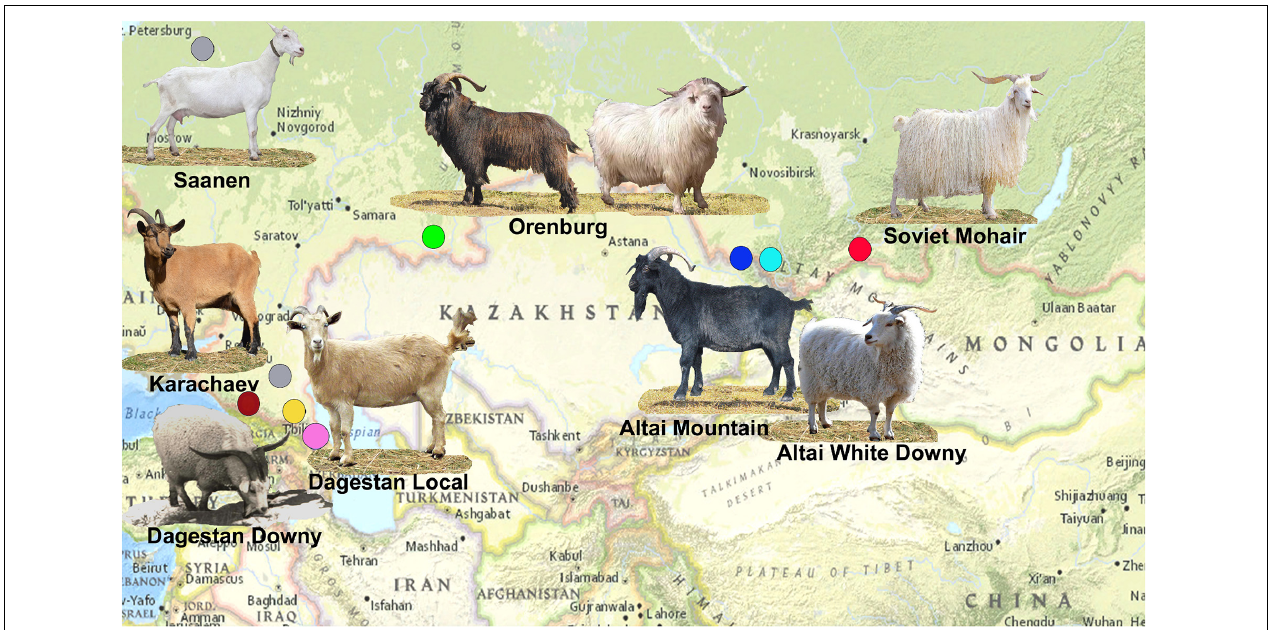
FIGURE 1 | Map illustrating the area of sampling for Russian goat populations. The sampling locations are shown as circles colored blue for Altai Mountain, cyan for Altai White Mountain, yellow for Dagestan Downy, pink for Dagestan Local, brown for Karachaev, green for Orenburg, gray for Saanen, and red for Soviet Mohair. The Orenburg breed is shown in two coat color variations. The photography of the Dagestan Downy goat was provided by Dr. Musalaev Khanmagomed and Dr. Rashid Abdullabekov (Federal Agrarian Scientific Center of the Republic of Dagestan). The photographs of the black Orenburg, Altai Mountain, and Soviet Mohair goats were taken by Irina Pridanova and obtained from Dunin and Dankvert (2013).